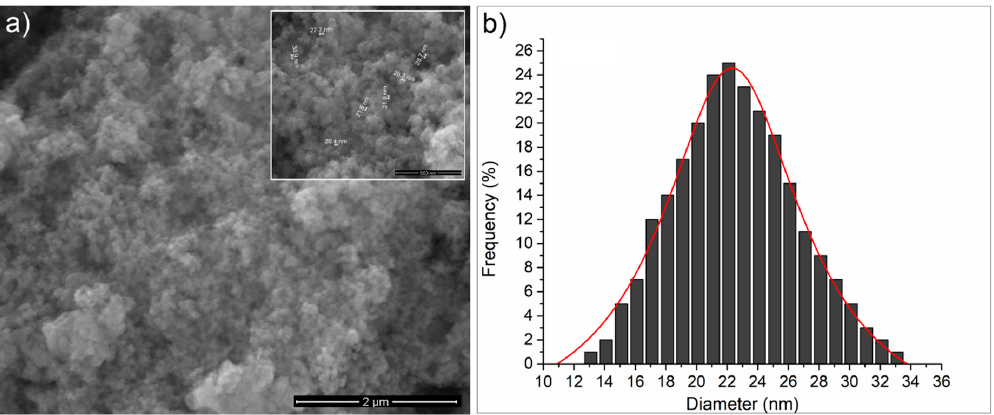
Figure 9. Representative image of ZnHApD powders ( a ) and size distributions ( b ) obtained by transmission electron microscopy (TEM). Scale bars = 100 nm.